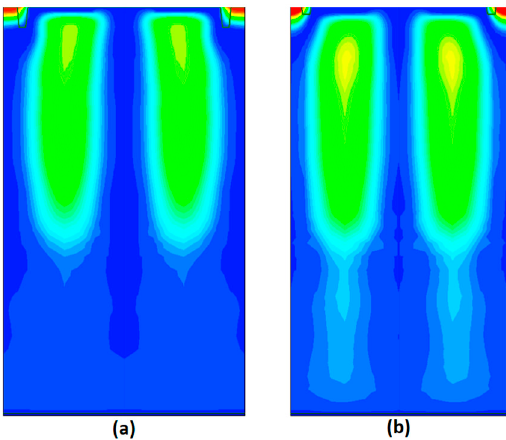
Figure 17. Three-dimensional TCAD simulations of photodiode showing electrostatic potential Three-dimensional TCAD simulations of photodiode showing electrostatic contours. ( a ) Two 0.9 µm pixels; ( b ) two 0.8 µm pixels. potential contours. ( a ) Two 0.9 µ m pixels; ( b ) two 0.8 µ m